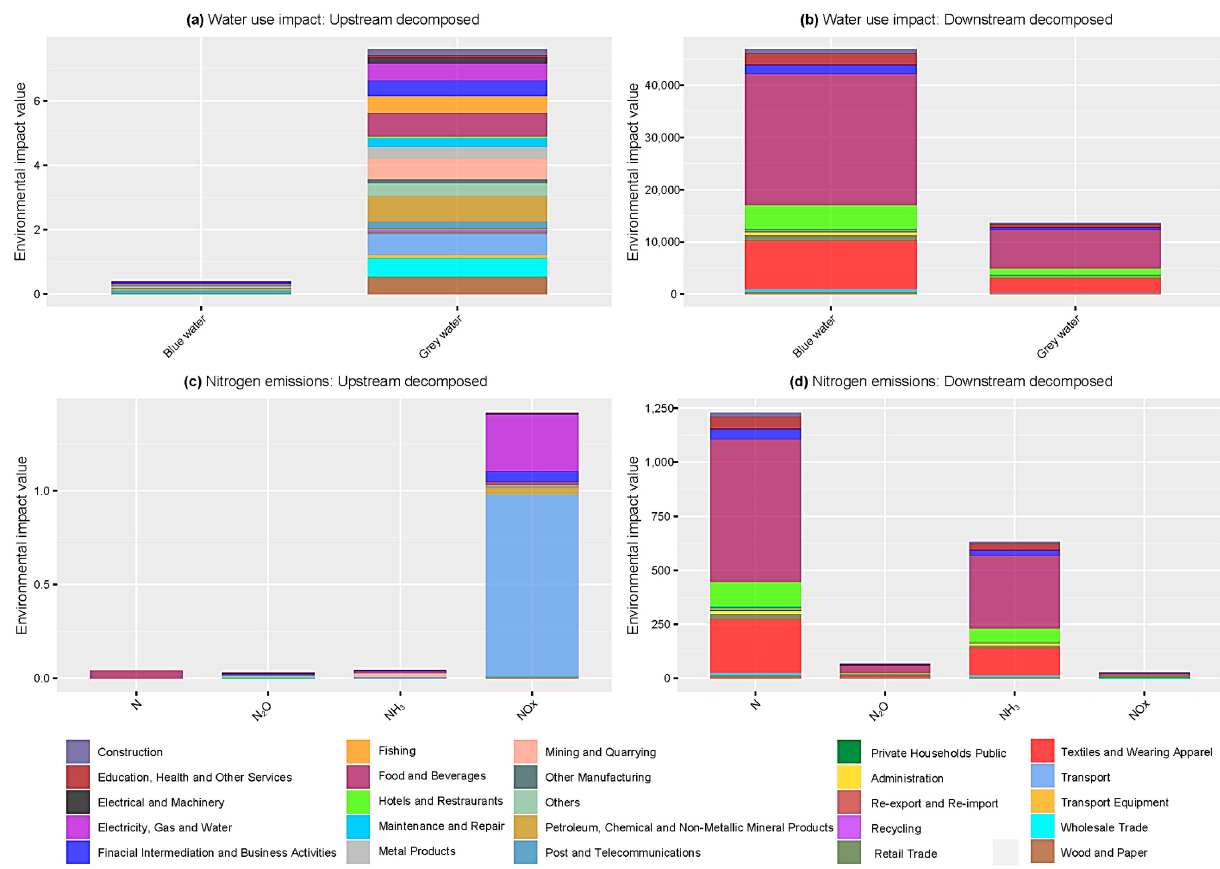
Figure 4. Further decomposition of water and nitrogen linkages of the agriculture sector. Here, the unit of nitrogen emissions is ‘Gg N’ and for the water use is ‘Mm 3 /yr’. ( a ) Water use impact: Upstream decomposed, ( b ) Water use impact: Downstream decomposed, ( c ) Nitrogen emissions: Upstream decomposed, ( d ) Nitrogen emissions: Downstream decomposed